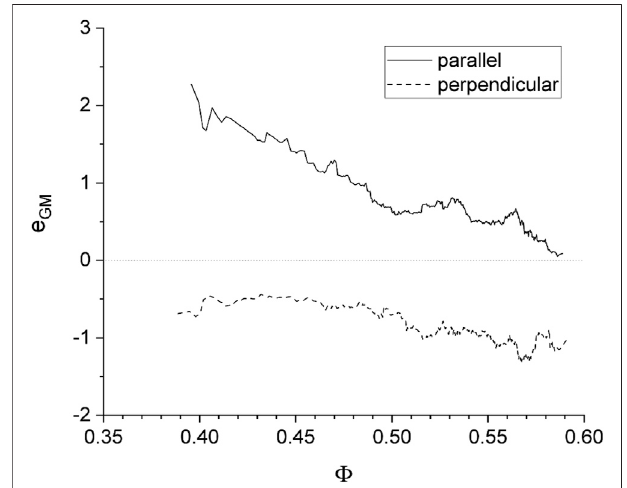
FIGURE 14 | Permeability comparison of SVEs, MVEs and Gebart ’ s equation for hexagonal fi ber arrays (Gebart, 1992) for axial and transverse fl ow.Thehighlightedareasshowthestandarddeviationofthemovingaverage of 30 cases for the MVEs and the standard deviation of the 10/20 SVEs per fi ber volume fraction generated. The grey crosses and lines mark the individual simulation results.